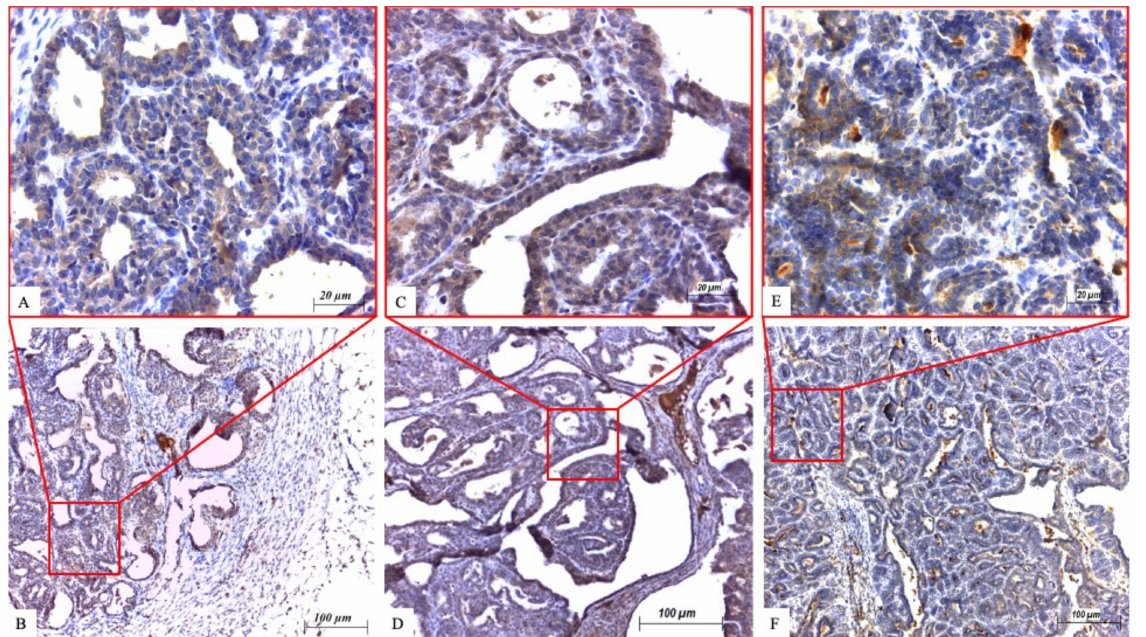
Figure 2. Immunohistochemical expression of proteins in carcinoma in situ. ( A , B ) ßIII-tubulin. ( C , D ) CA IX. ( E , F ) Survivin. Scale bars ( A , C , E ) 20 µ m; ( B , D , F ) 100 µ m. The upper images show the area with the red rectangle on lower images at higher